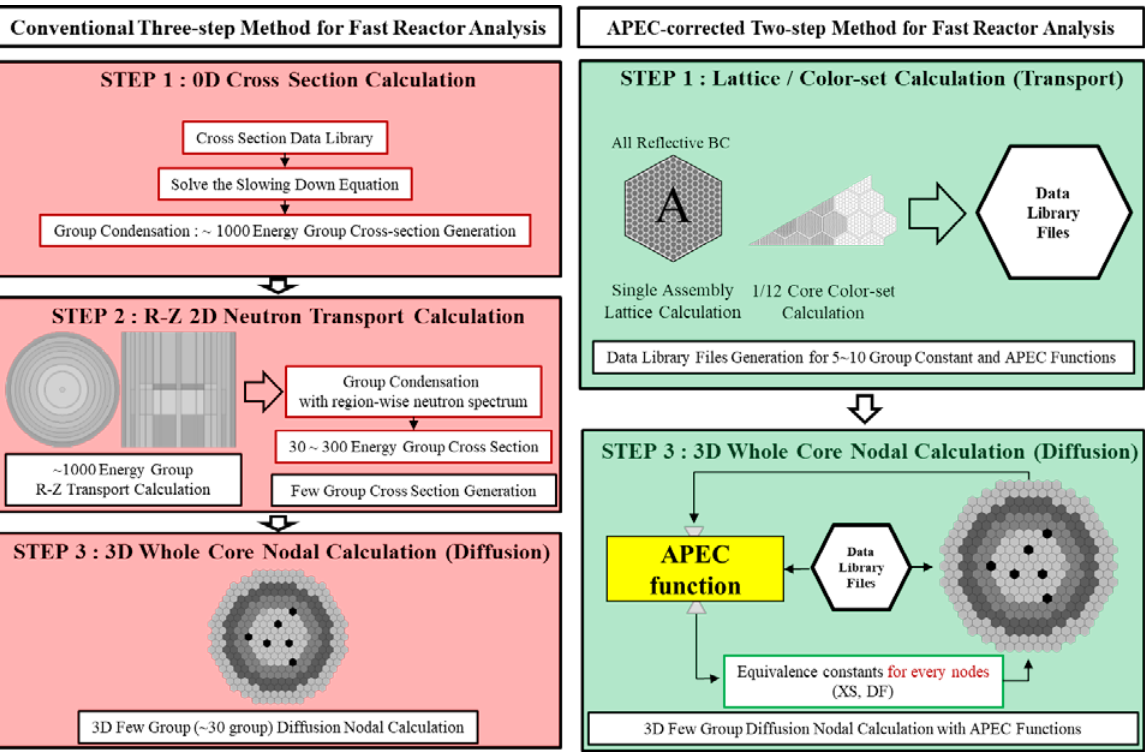
Figure 1. Comparison between Conventional Three-step and APEC-corrected Two-step